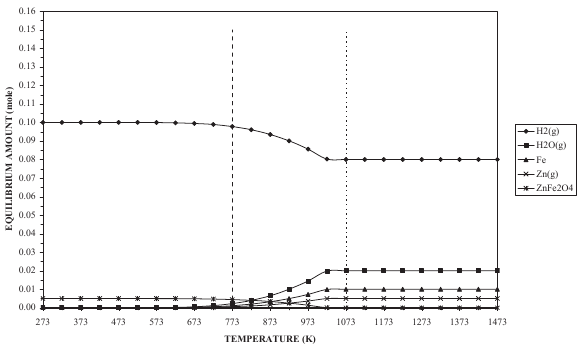
Figure 7. Equilibrium amounts of zinc ferrite with zinc and iron products as a function of temperature in the presence of 5 times over the stoichimetric amount hydrogen and water